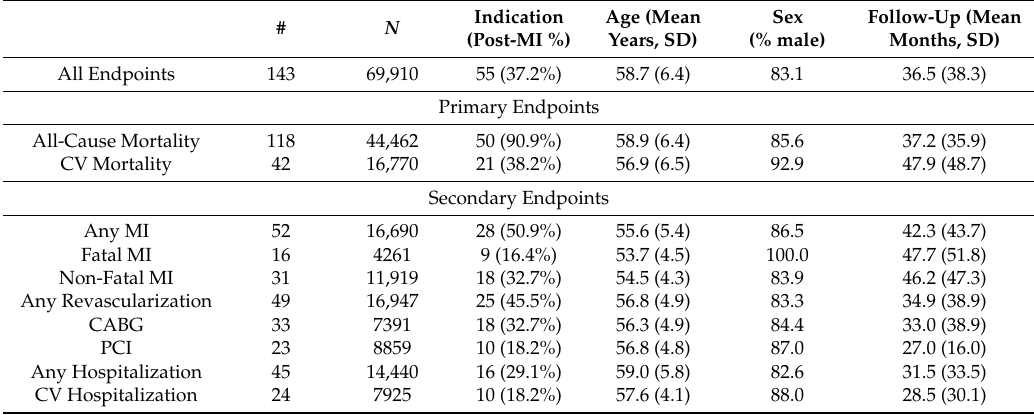
Table 1. Characteristics of included patients and trial follow-up time by endpoint. #